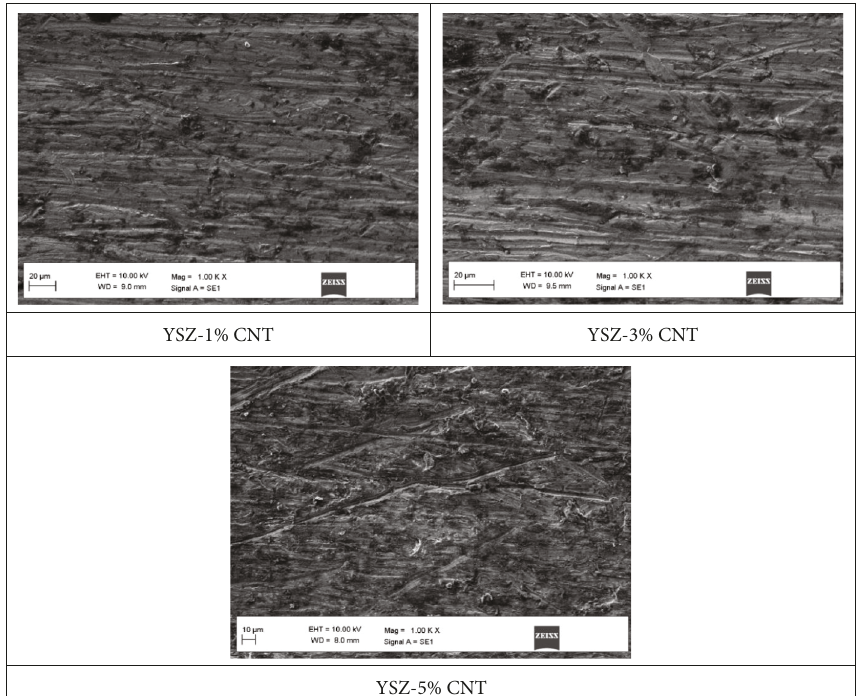
Figure 10: Surface topography of worn surface with different combination of CNT in YSZ